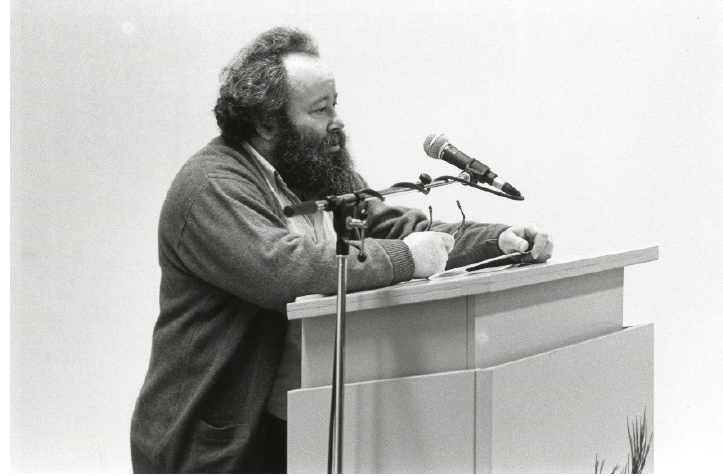
Figure 10. Jen Lissitzky speaking at the opening of the exhibition ‘El Lissitzky’, Van Abbemuseum, 15 December 1990. Photo from Van Abbemuseum exhibition archive. Photographer unknown.